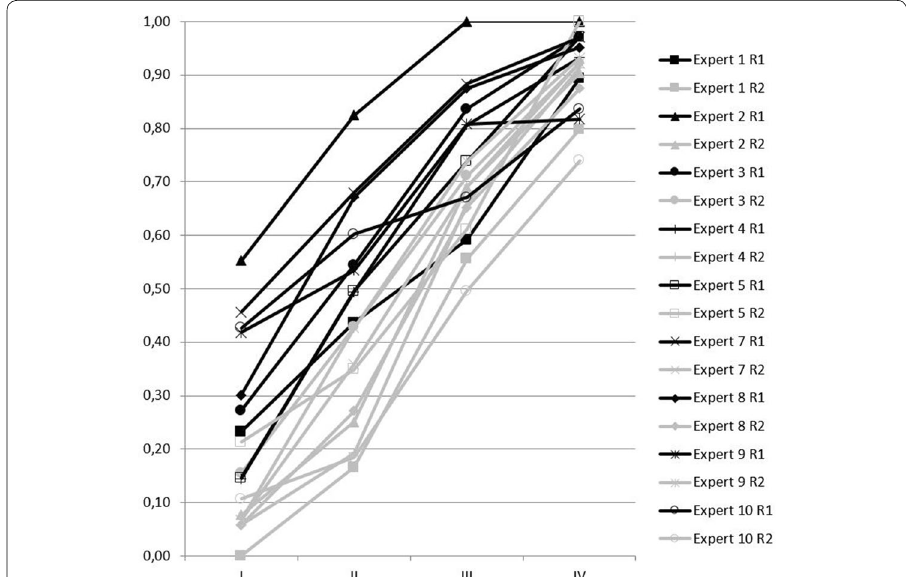
Fig. 2 Ratings of the experts for each cut score by round (integrated results). Values of the same round share the same color, values of the same expert share the same marker. Expert 6 did not show up at the workshop. R